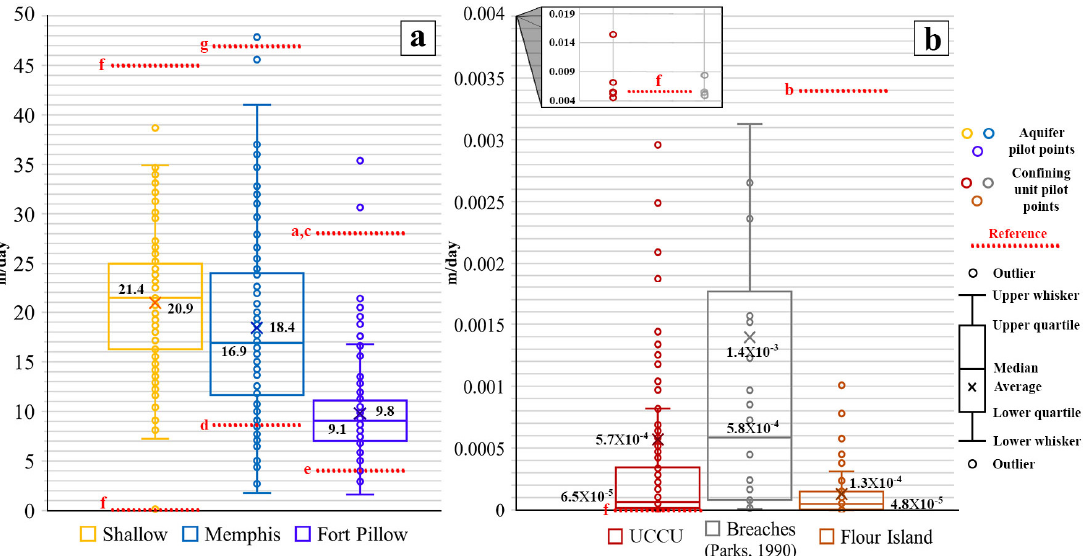
Figure 11. Calibrated hydraulic conductivity values at pilot points: ( a ) aquifers and ( b ) confining units. Published values from Table 1 are displayed as dashed lines with their corresponding references: a Schneider and Cushing [54], b Graham and Parks [32], c Parks and Carmichael [55], d Parks and Carmichael [56], e Carmichael et al. [33], f Robinson et al. [5], and g Gentry et al. [57].